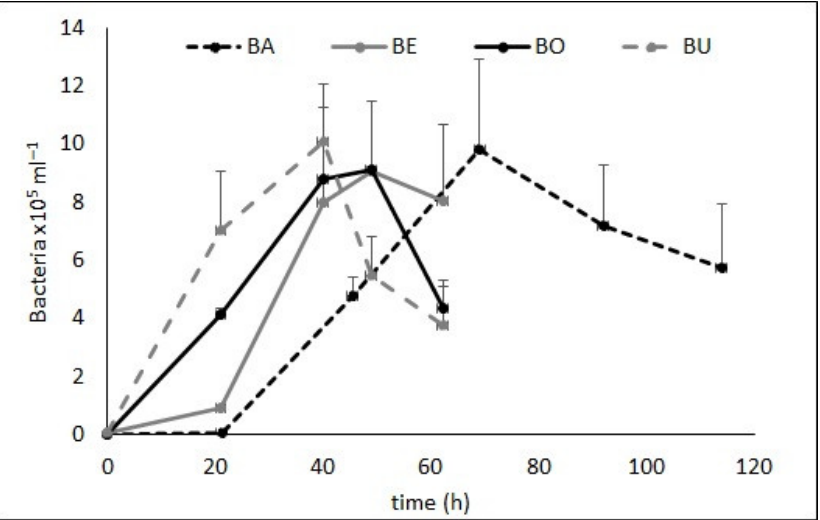
Figure 1. Growth of free-living bacteria in the microcosms inoculated with bacteria attached to mi- croplastics. Error bars: minimum–maximum values for BO, BE, and BU and standard deviation for BA. BA: plastic bag, BO: polyethylene bottle, BE: acrylic beads, BU: cigarette butts.